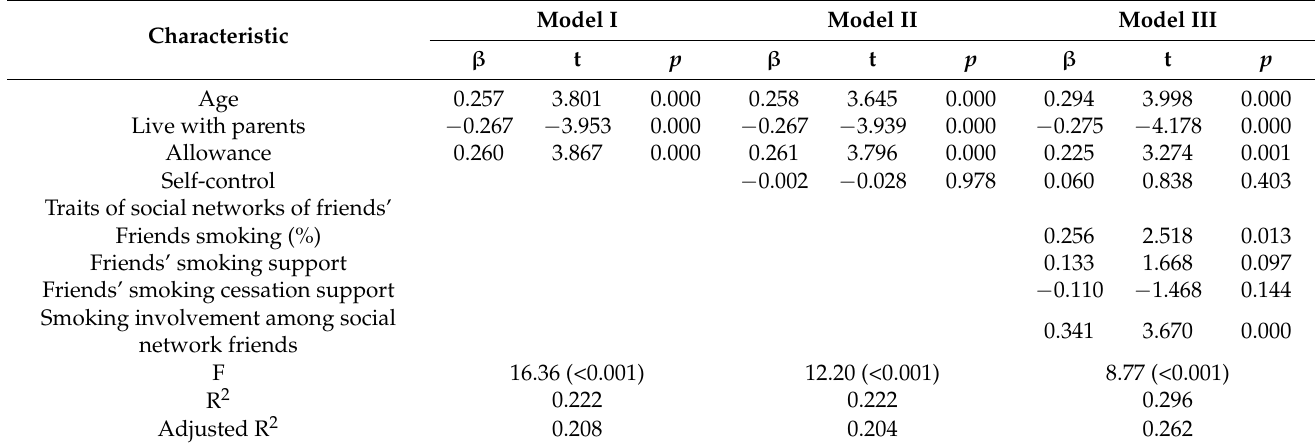
Table 4. Factors influencing the smoking amount of out-of-school adolescents ( N =